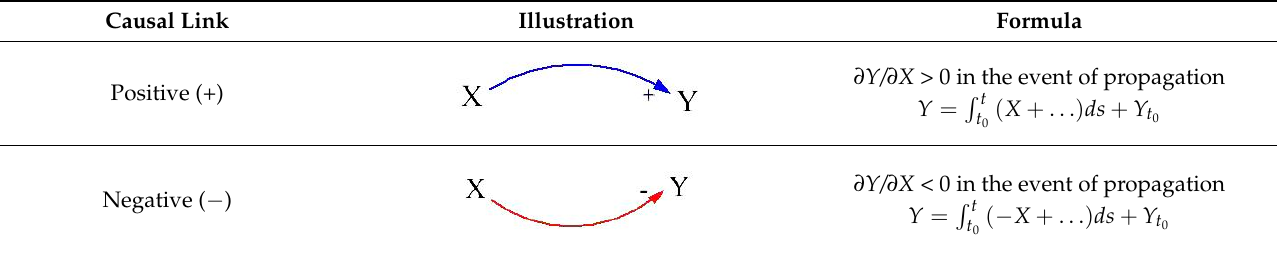
Table 1. Polarity of causal links and graphic illustration [23].